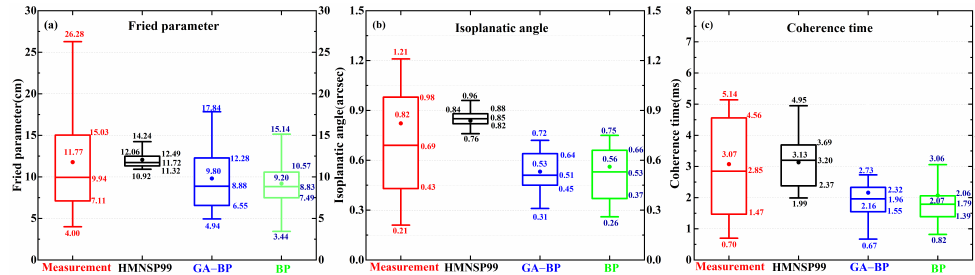
Figure 12. Box plot for integrated parameters between GA-BP, BP and HMNSP99 models. ( a ) Fried parameter. ( b ) Isoplanatic angle. ( c ) Coherence